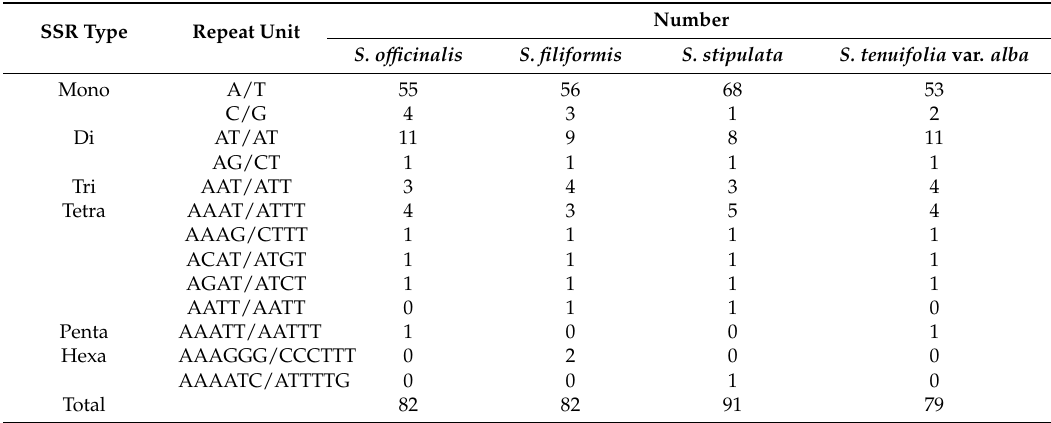
Table 5. Types and numbers of SSRs found in the four Sanguisorba chloroplast